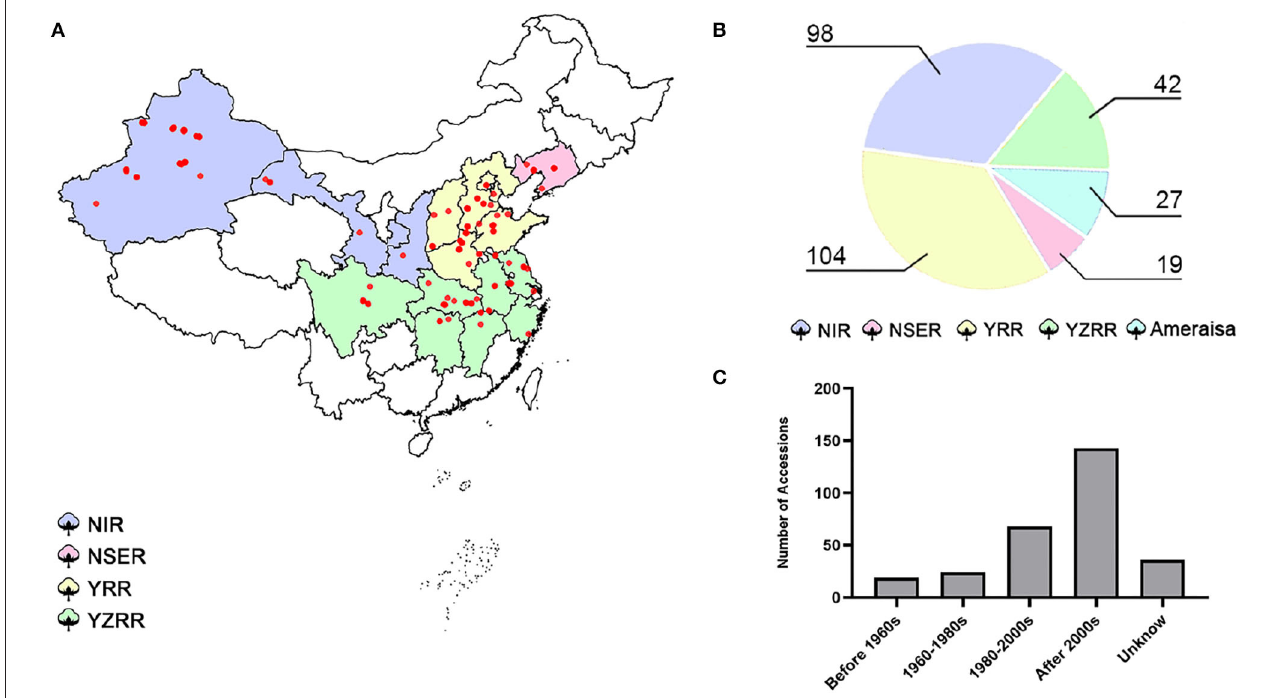
FIGURE 1 | Map of the 290 cotton accessions. (A) Geographic distribution of the natural population; each accession is represented by a dot. (B) Pie chart of the proportions of diverse cotton-growing areas in 290 accessions. NIR: Northwest Inland region in China; NSER: Northern-Specific Early-Maturity region; YRR: Yellow River region; YZRR: Yangtze River region; and Amerasian: 27 accessions primarily introduced from six different countries (USA, Azerbaijan, Israel, Kyrgyzstan, Tajikistan, and Uzbekistan). (C) Breeding stage distribution of the GWAS panel; Unknown: accessions that were not found among the pedigrees.